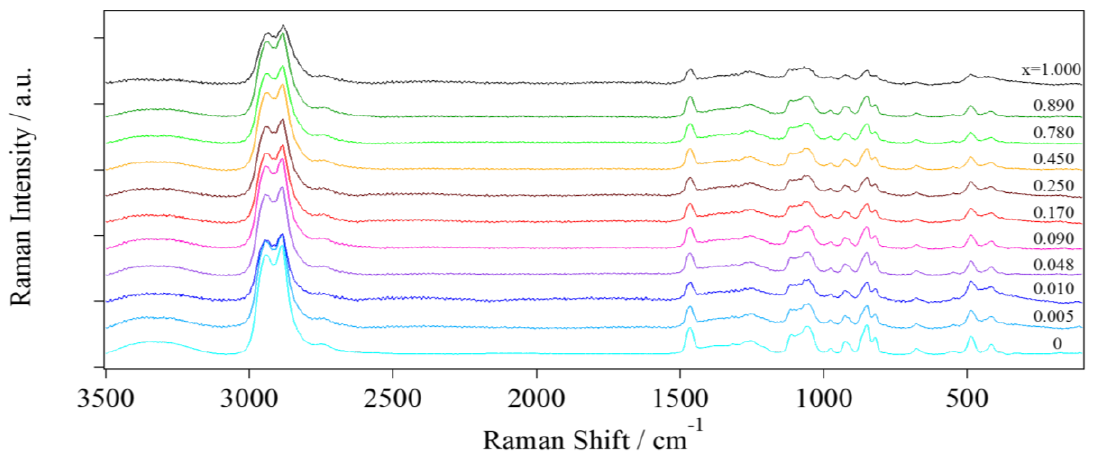
Figure 6. Normalized micro-Raman spectra of GlyLi x samples.